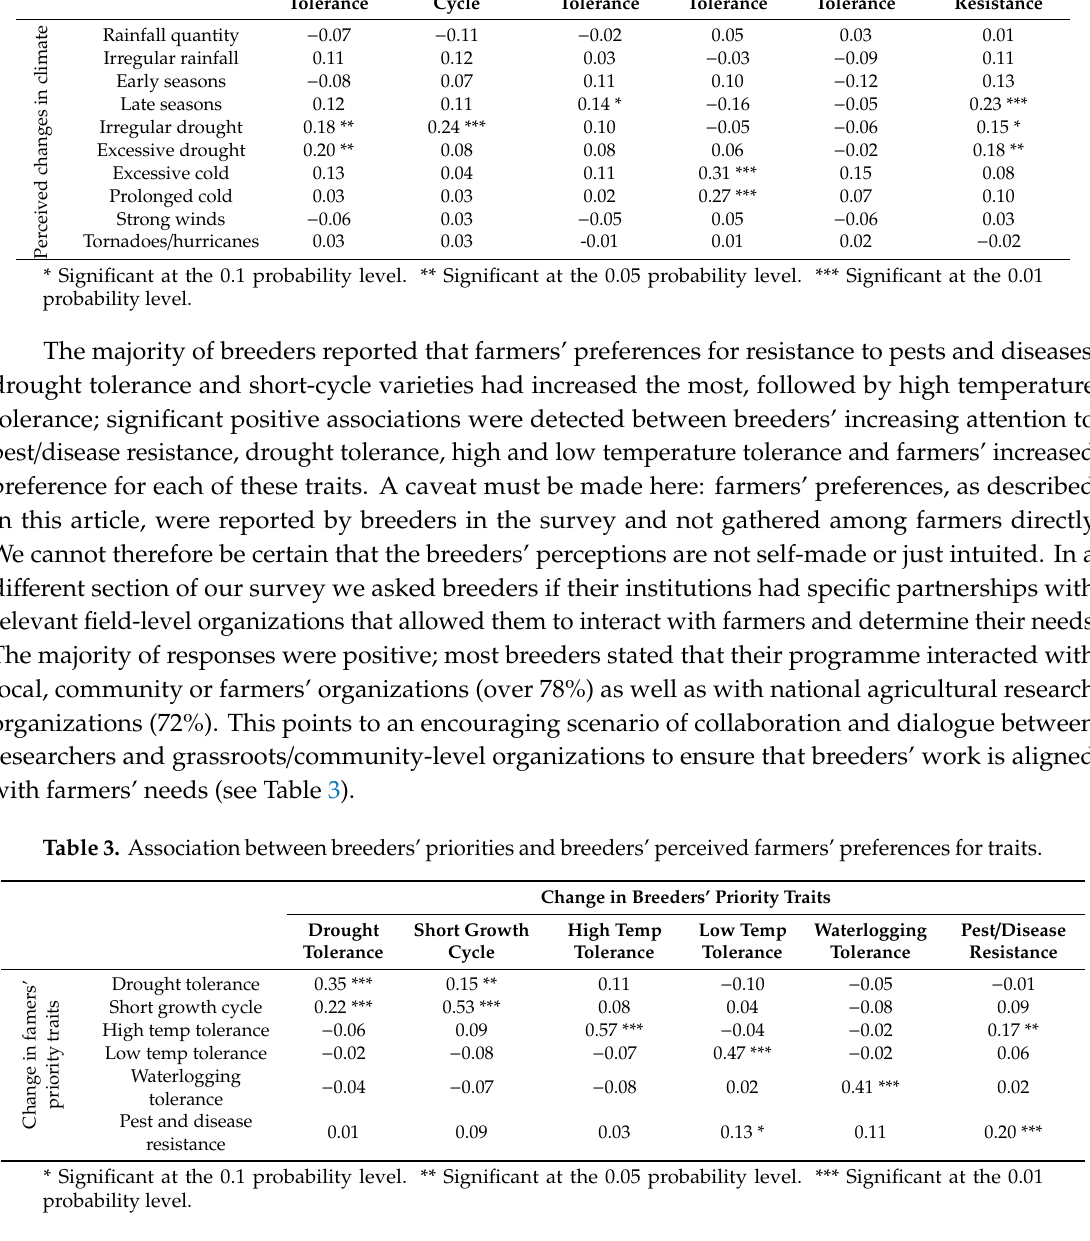
Change in Breeders’ Priority Traits Drought Short Growth High Temp Low Temp Tolerance Cycle Tolerance Tolerance